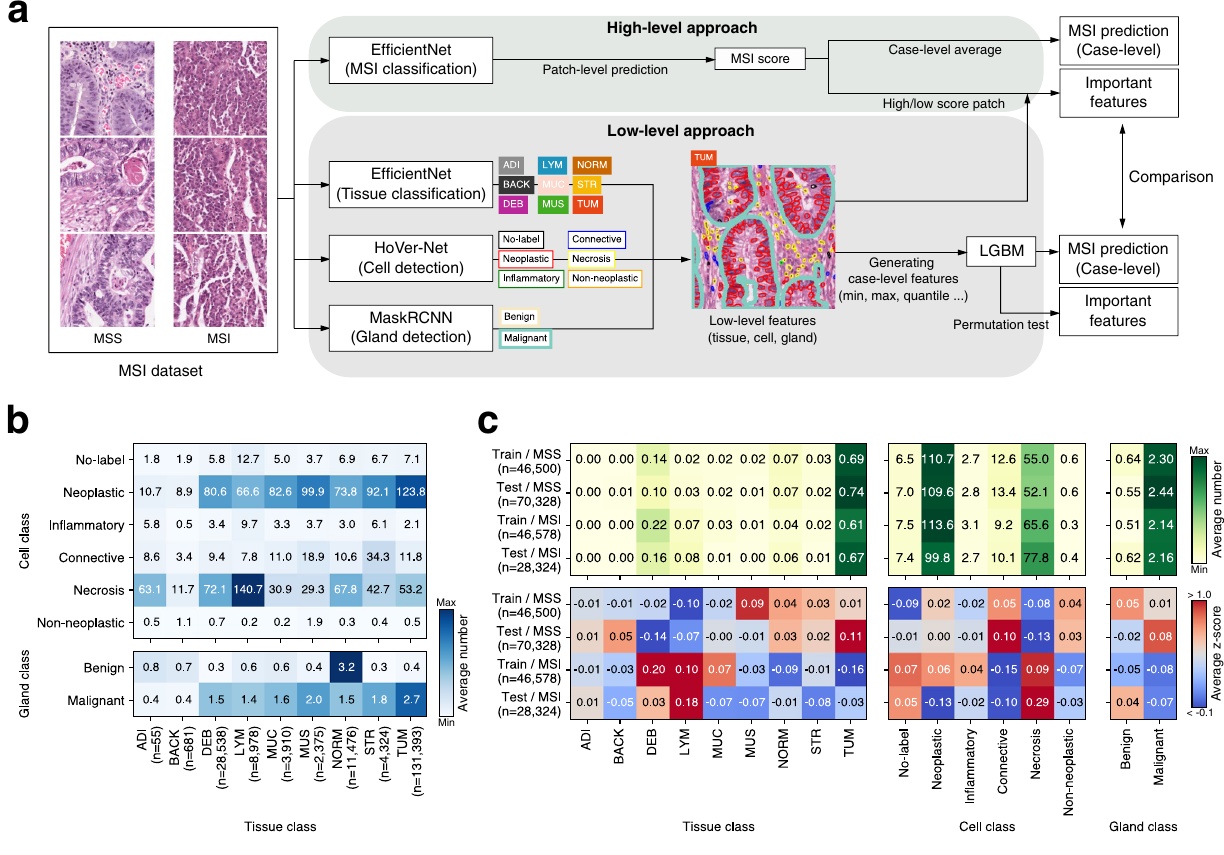
Figure 1. Conceptual view comparing high-/low-level approaches and dataset analysis of low-level features. ( a ) Pipeline for high and low-level approaches. The high-level approach uses high-level image features that utilize the deep learning architecture EfficientNet to predict microsatellite instability ( MSS microsatellite stable, MSI microsatellite instable) directly from image patches. The low-level approach utilizes low-level features such as the number of tissues, cells, and glands. After defining and generating case-level features from low-level features, LightGBM predicts MSI from the features. ( b ) Correlations among low-level features derived from both the training and test sets from the colorectal cancer (CRC) cohort. ( c ) Low-level image features of the training and test sets of the CRC cohort. Average number (top) and z score (bottom). ADI adipose tissue, BACK background, DEB debris, LYM lymphocytes, MUC mucus, MUS smooth muscle, NORM normal colon mucosa, STR cancer- associated stroma, TUM colorectal adenocarcinoma epithelium. The heatmaps were created with Python v3.8.8 (https:// www. python. org) and Matplotlib v3.4.3 (https:// www. matpl otlib. org). The figure was generated using Inkscape v1.1 (https:// inksc ape.